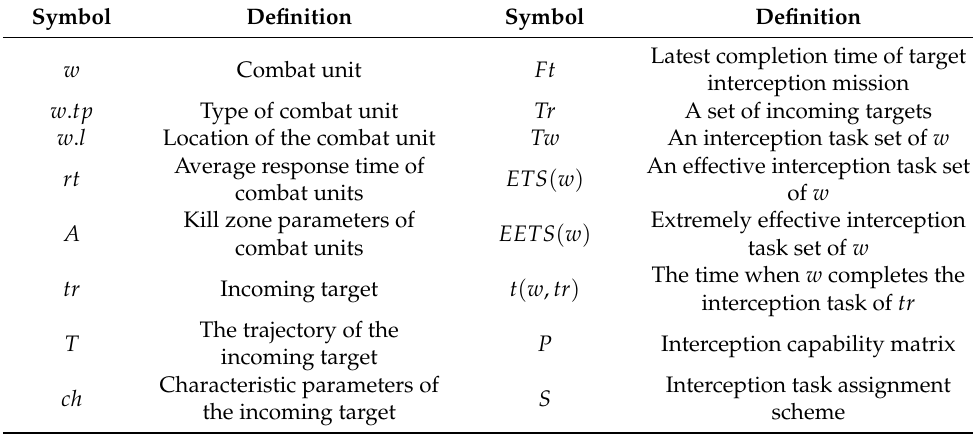
Table 1. Summary of